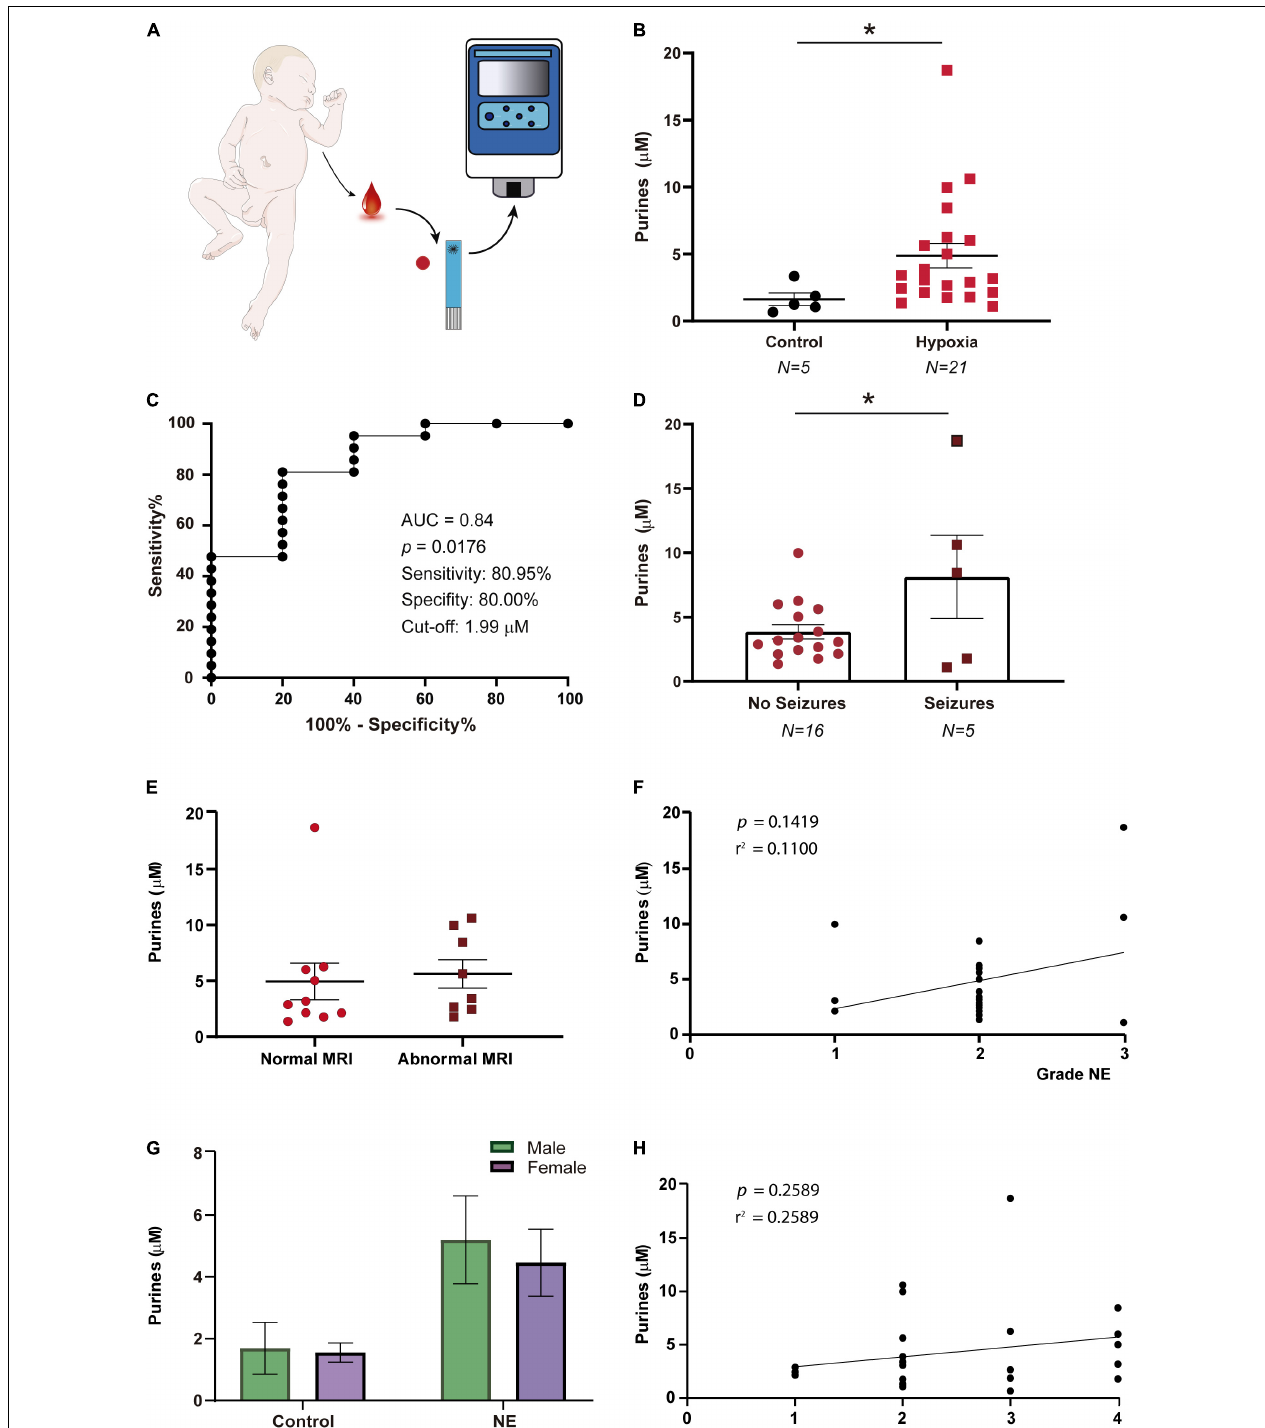
FIGURE 2 | Purine concentration changes in infants with neonatal encephalopathy. (A) Blood purine concentration was analyzed in whole blood via SMARTchip 1–4 days post-delivery. (B) Increased blood purine concentrations in infants with NE ( N = 15) when compared to healthy controls ( N = 5), Mann-Whitney test ( p = 0.0155). (C) ROC analysis shows blood purine concentration had a 80.95% sensitivity, 80.00% specificity and AUC of 0.84 for identifying infants with NE at a cut-off of 1.99 µ M. (D) Graph showing blood purine concentrations measured in infants with NE are higher in the presence of seizures ( N = 16 (NE without seizures) and 5 (NE with seizures), Unpaired Student’s t -test ( t = 2.160; df = 19; p = 0.044). (E) Graph showing no correlation between purine concentrations when comparing